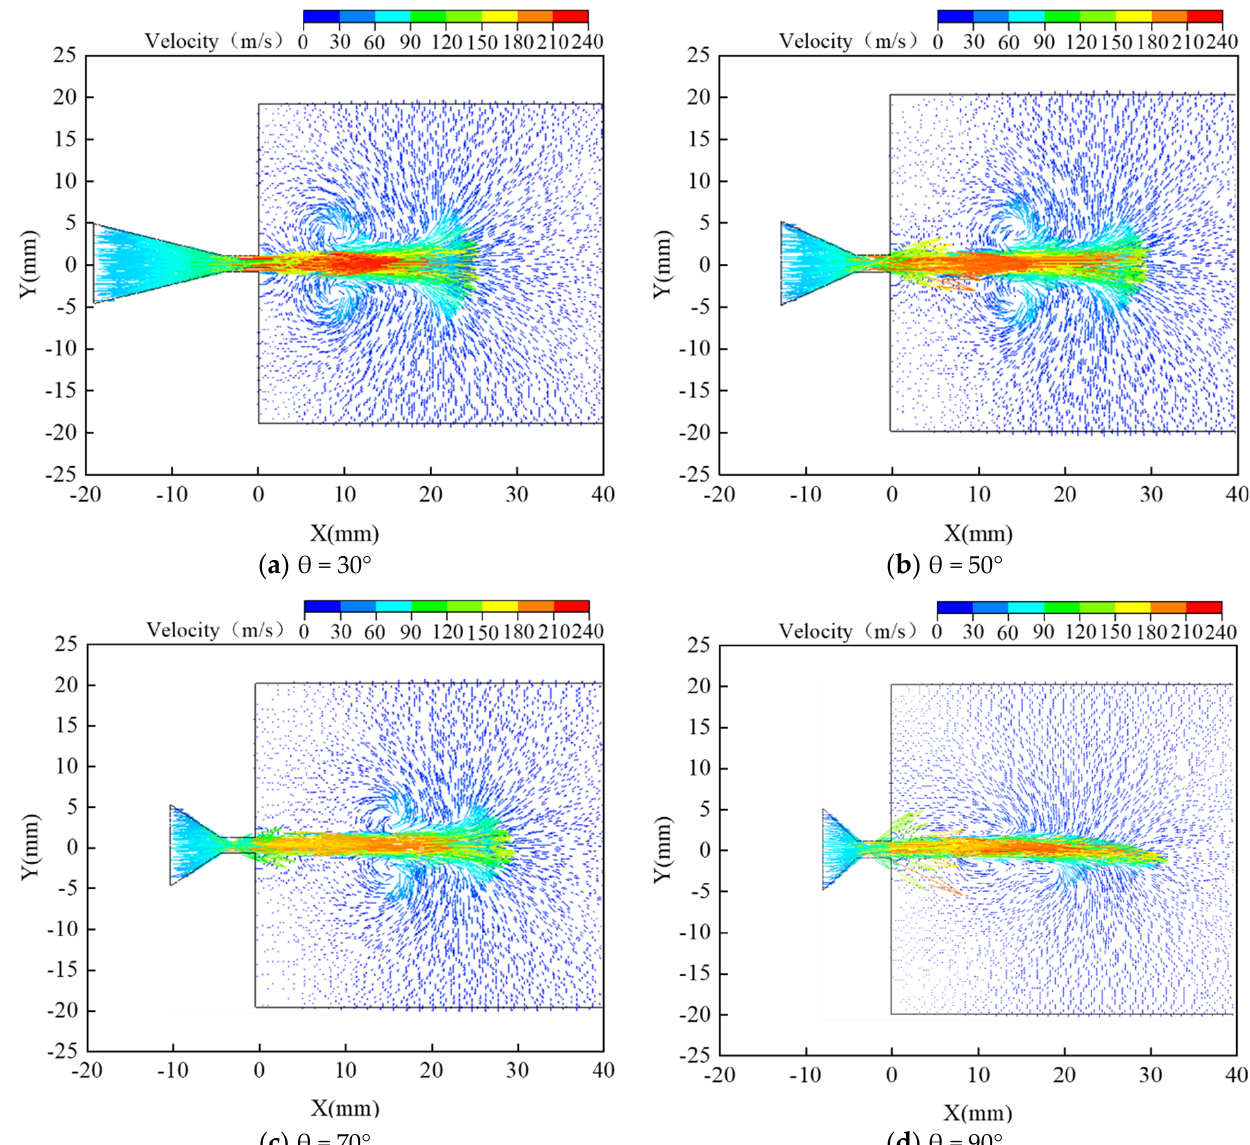
Figure 10. Velocity vector of the flow field when t = 0.02